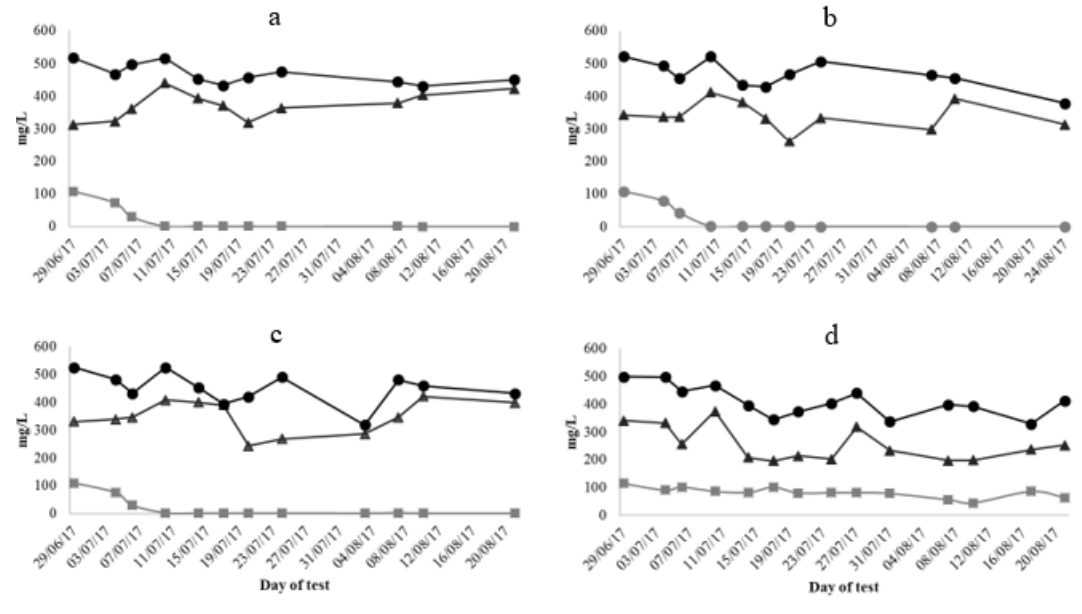
Figure 5. Evolution of ammonium-nitrogen, nitrate-nitrogen and total nitrogen in each IBC exposed to different aeration periods. ( a ) Treatment A (constant aeration), ( b ) Treatment B (intermittent aeration 4h AA:4h no-AA), ( c ) Treatment C (intermittent aeration 6h AA:4h no-AA), ( d ) Treatment D (no aeration), AA= aeration.